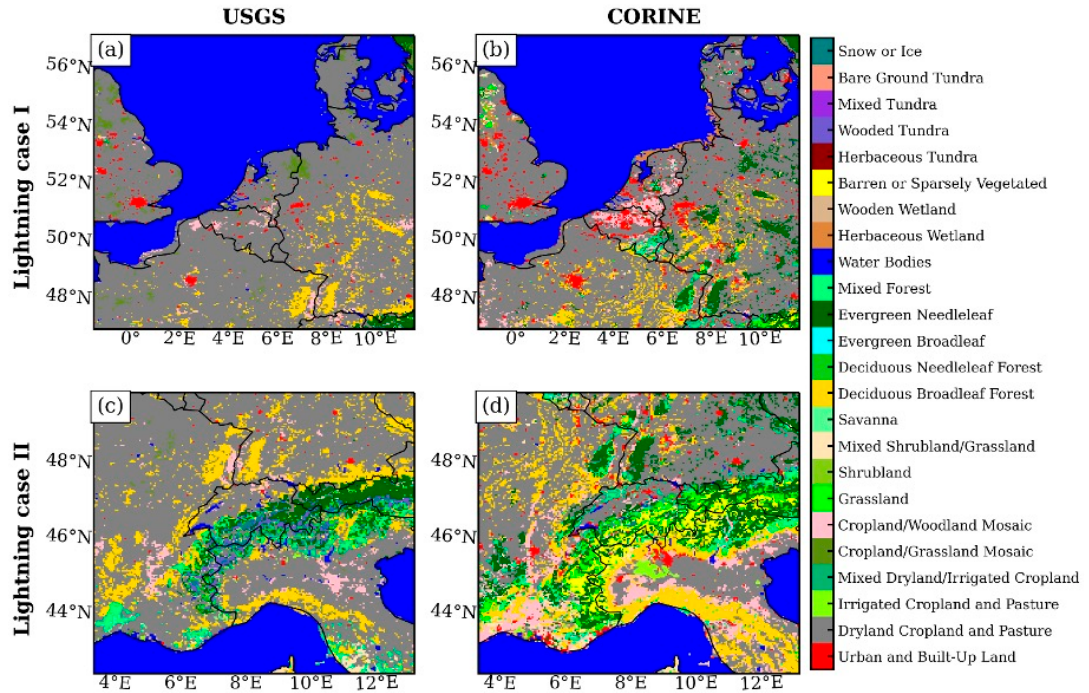
Figure 2. Geographical representation of the main land-use category classes with domains for ( a , b ) Case I: 18 August 2011 (first row) and ( c , d ) Case II: 29 July 2013 (second row). The first column shows default USGS LULC, and the second column shows updated Corine LULC.